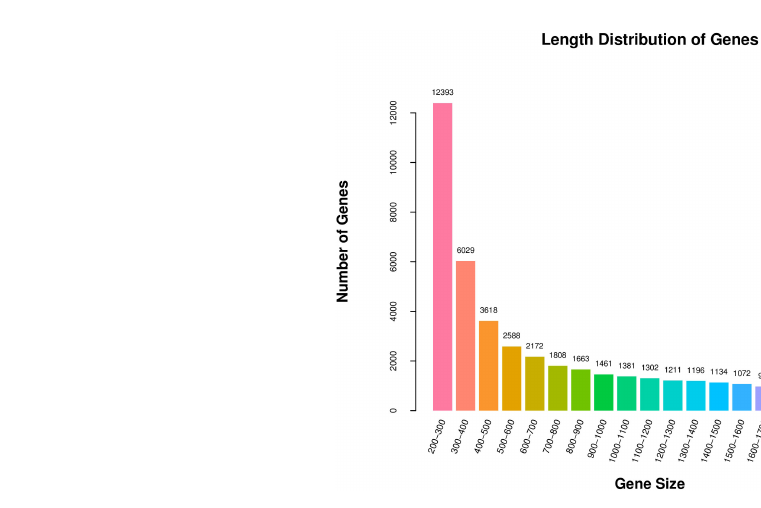
FIGURE 2 The length distribution of Unigenes in